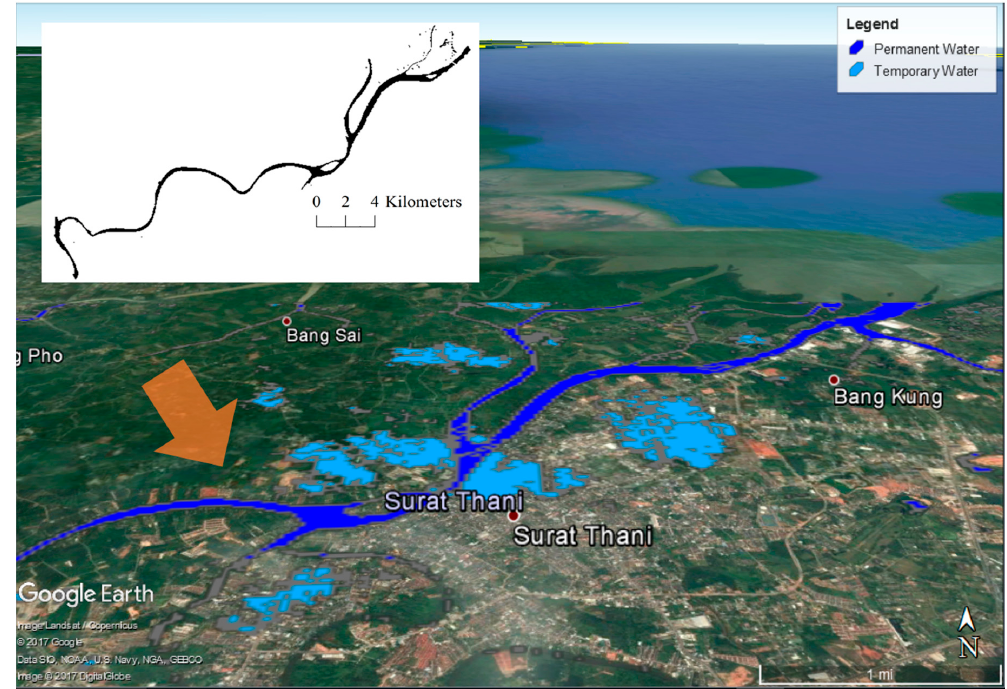
Figure 9. Discrimination between the Tapi River in dark blue and the flooded areas in light blue in the Muang district, Surat Thani. ISPRS Int. J. Geo-Inf. 2017 , 6 , 301